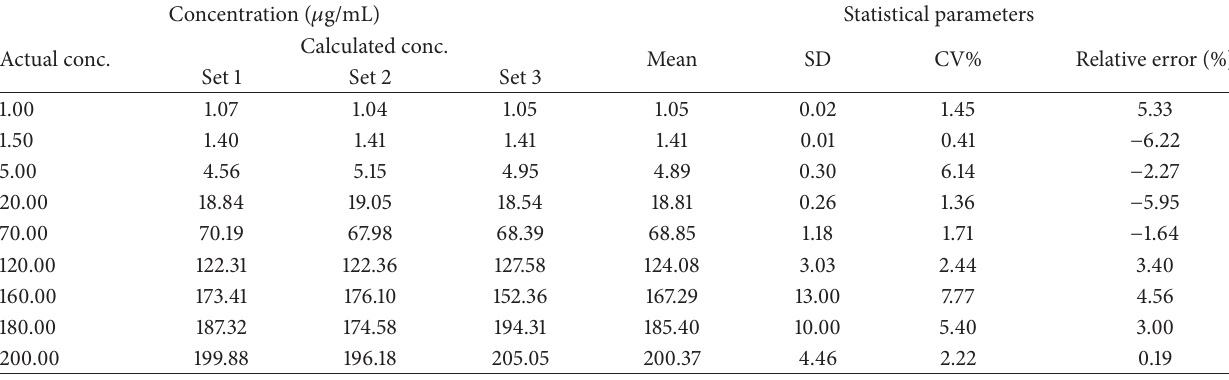
Table 1: Calculated concentrations and statistical parameters of CrEL-PEG calibration standards prepared in rat plasma ( 𝑛 = 3 ).